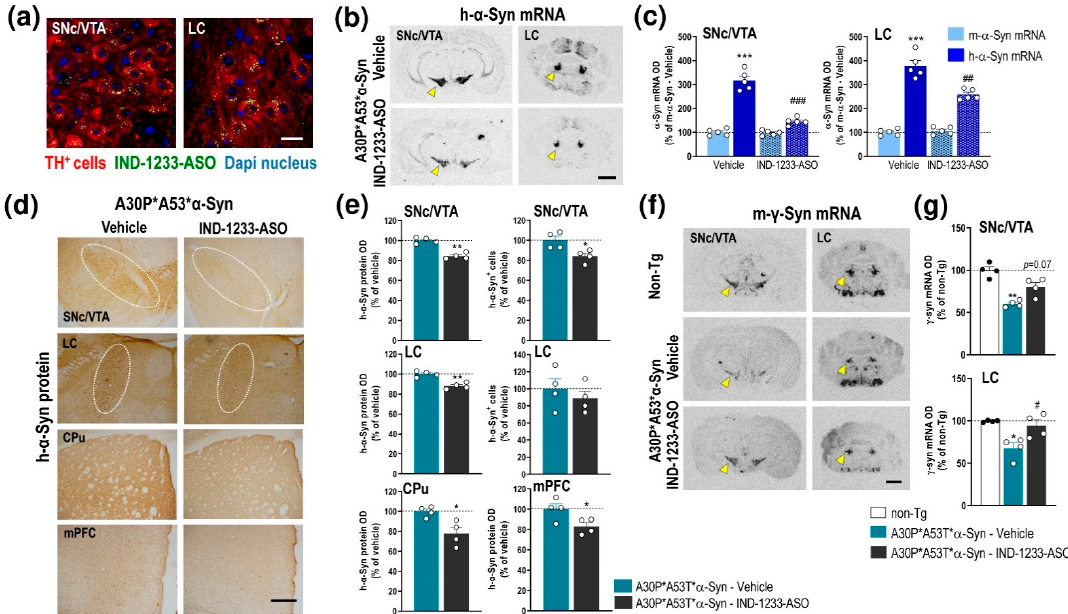
Figure 5. Intracerebroventricular IND-1233-ASO treatment selectively inhibits the expression and accumulation of h- α - Syn in interconnected DA and NE brain regions of A30P*A53T* α -Syn transgenic mice. ( a ) Confocal images showing the co-localization of A488-IND-1233-ASO (green) with TH + neurons (red) in the SNc/VTA and LC. Cell nuclei were stained with DAPI (blue). Scale bar: 10 µ m. ( b ) Coronal brain sections showing reduced h- α -Syn mRNA expression in the SNc/VTA and LC of A30P*A53T* α -Syn mice treated with IND-1233-ASO (100 µ g/day for 28 days), as assessed by in situ hybridization. Yellow arrowheads show h- α -Syn mRNA expression in SNc/VTA and LC. Scale bar: 1 mm. ( c ) Bar graphs showing significant reductions in h- α -Syn mRNA levels, but not m- α -Syn mRNA, in SNc/VTA and LC of IND-1233- ASO-treated A30P*A53T* α -Syn mice ( n = 5 mice/group; *** p < 0.001 vs. m- α -Syn mRNA levels; ## p < 0.01, ### p < 0.001 vs. vehicle-treated A30P*A53T* α -Syn mice; two-way ANOVA and Tukey’s multiple comparisons test). ( d ) Representative photomicrographs showing a lower h- α -Syn protein density in the SNc/VTA, LC, CPu and mPFC of IND-1233-ASO-treated A30P*A53T* α -Syn mice vs. vehicle-treated A30P*A53T* α -Syn mice. White frames indicate SNc/VTA and LC brain regions. Scale bar: 200 µ m. ( e ) Bar graphs showing significant reductions in h- α -Syn protein levels in the brain areas analyzed, as well as a decreased number of h- α -Syn + cells in the SNc/VTA of IND-1233-ASO-treated A30P*A53T* α -Syn mice ( n = 4 mice/group; * p < 0.05, ** p < 0.01 versus vehicle-treated A30P*A53T* α -Syn mice; Student’s t -test). ( f ) Representative images showing increased m- γ -Syn mRNA expression in SNc/VTA and LC of A30P*A53T* α -Syn mice treated with IND-1233-ASO as assessed by in situ hybridization. Yellow arrowheads show m- γ -Syn mRNA expression in SNc/VTA and LC. Scale bar: 1 mm. ( g ) Bar graphs showing significant increases in m- γ -Syn expression in the LC and a marginal effect in the SNc/VTA of IND-1233-ASO-treated A30P*A53T* α -Syn mice ( n = 4 mice/group; * p < 0.05, ** p < 0.01 vs. non-Tg mice; # p < 0.05 vs. vehicle-treated A30P*A53T* α -Syn mice; one-way ANOVA). For all figures, data are the mean ± SEM. Abbreviations: mPFC, medial prefrontal cortex; CPu, caudate putamen; SNc, substantia nigra compacta; VTA, ventral tegmental area; LC, locus coeruleus. See also Supplemental Figure